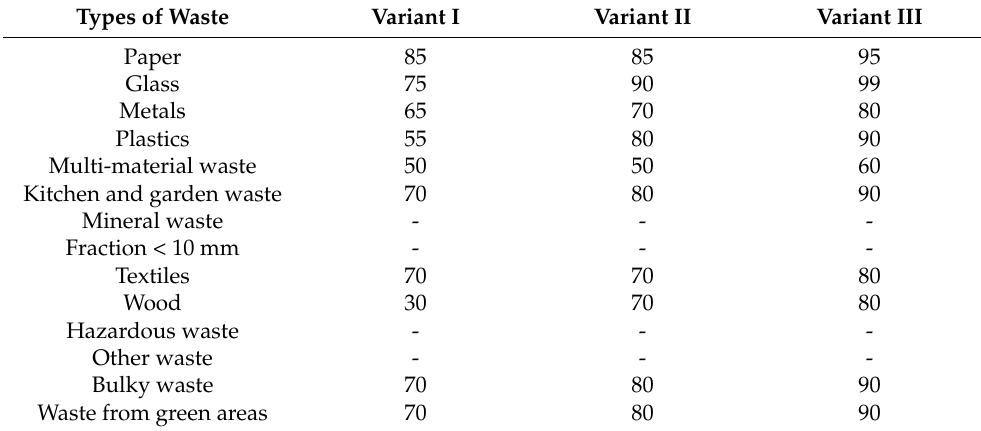
Table 9. The required level of recycling of individual fractions of municipal waste according to circular economy assumptions